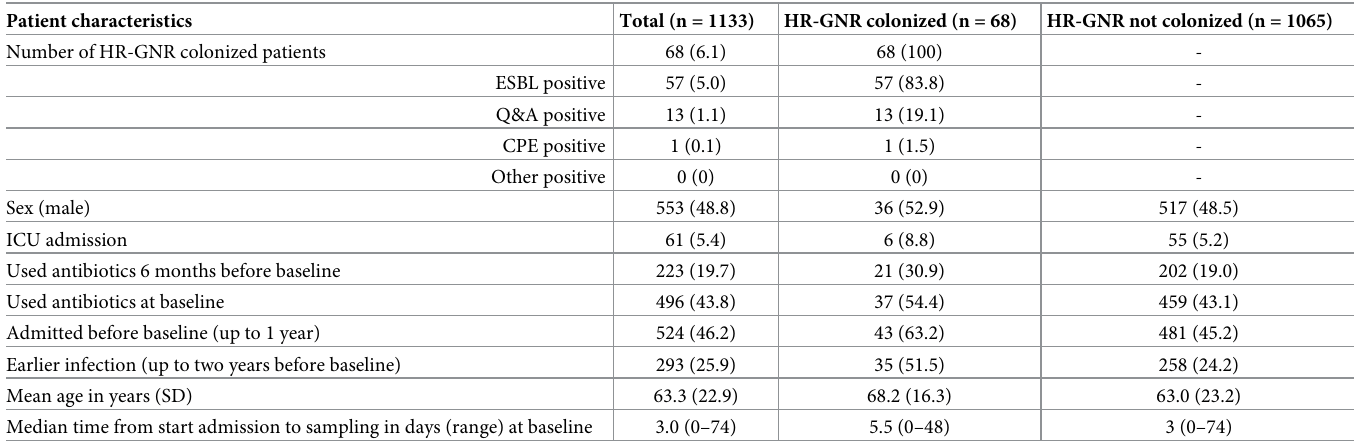
Table 1. Baseline characteristics of the